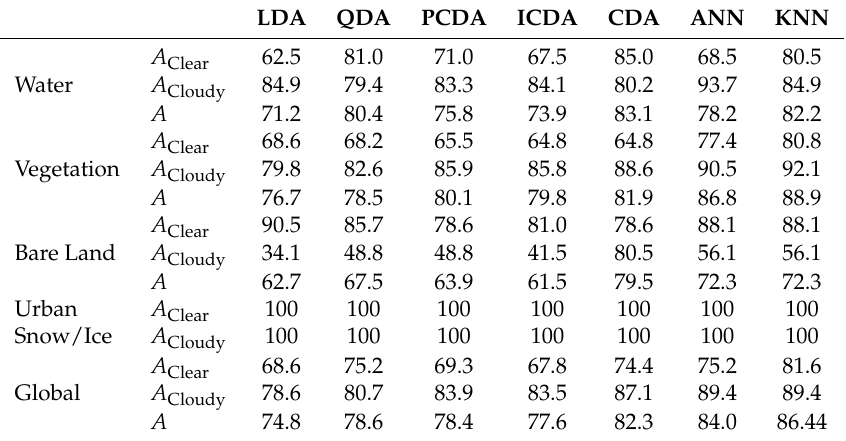
Comparison of Table 7 with Table 5 does not provide unique indications: most methods show a certain degree of decrease of accuracy around 1% globally (only LDA reaching −